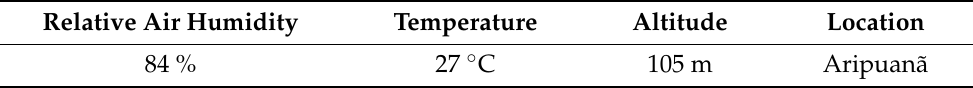
Table 1. Environmental conditions on the collection day (15 January 2020).